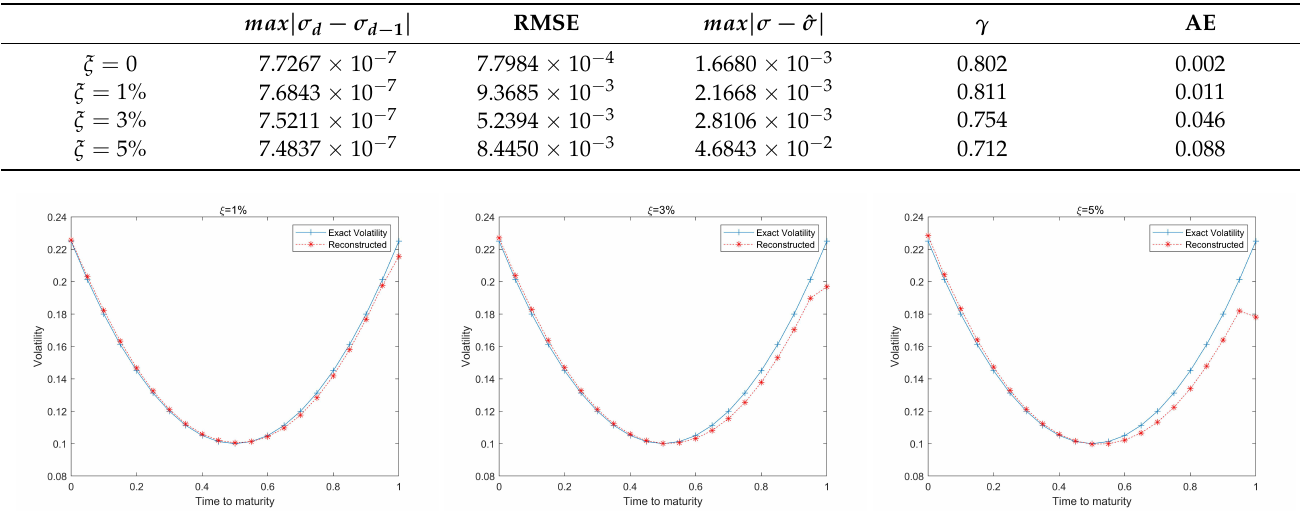
Figure 3. Comparison between the recovered and exact volatility for Example 2. Table 3. The numerical results of recovered σ ( τ ) and γ .